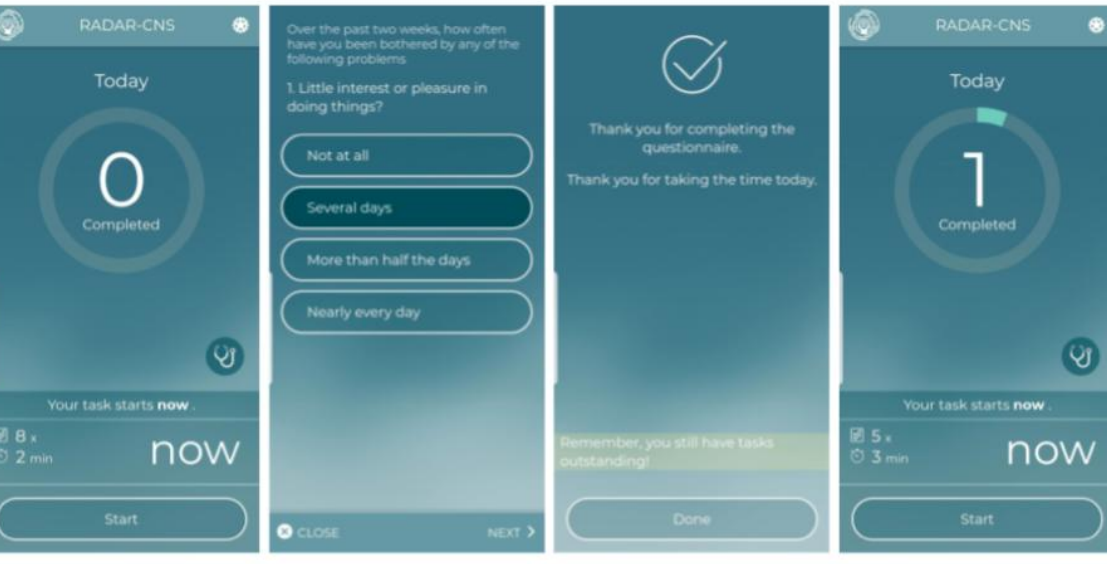
Figure 5. User interface of the active Remote Monitoring app.